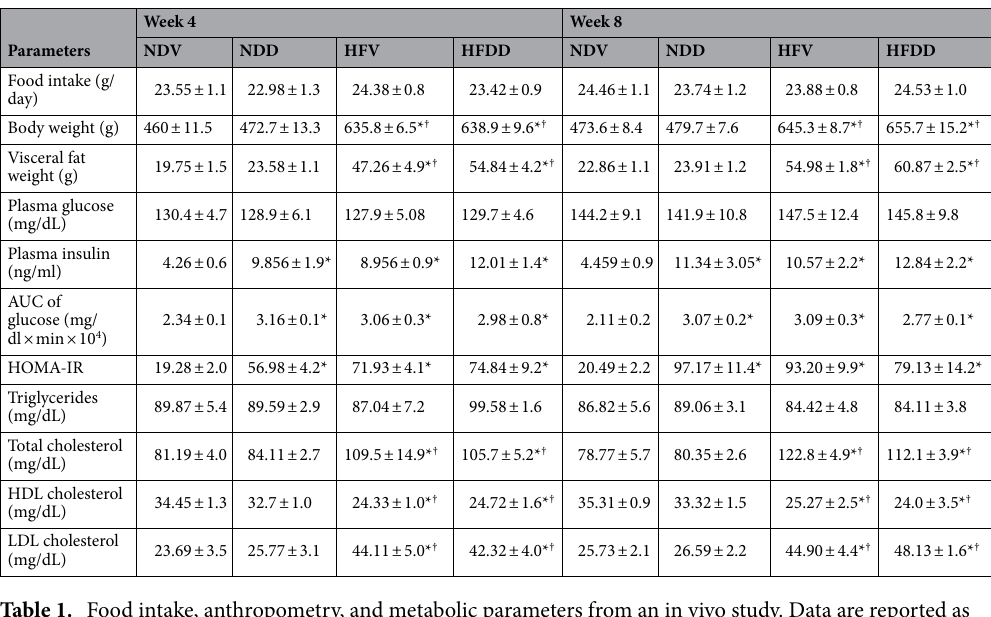
Table 1. Food intake, anthropometry, and metabolic parameters from an in vivo study. Data are reported as mean ± SEM (n = 6/group). * p < 0.05 versus NDV at the same time point. † p < 0.05 versus NDD at the same time point. ‡ p < 0.05 versus HFV at the same time point. # p < 0.05 versus same group at the different time point.